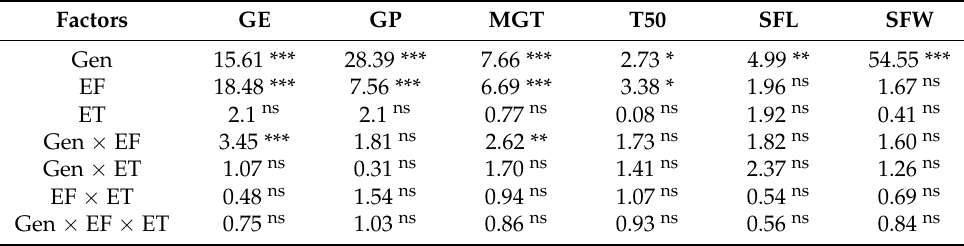
Table 2. Analysis of variance (mean squares) for different parameters of 5 soybean genotypes after applied DC voltage (electrostatic